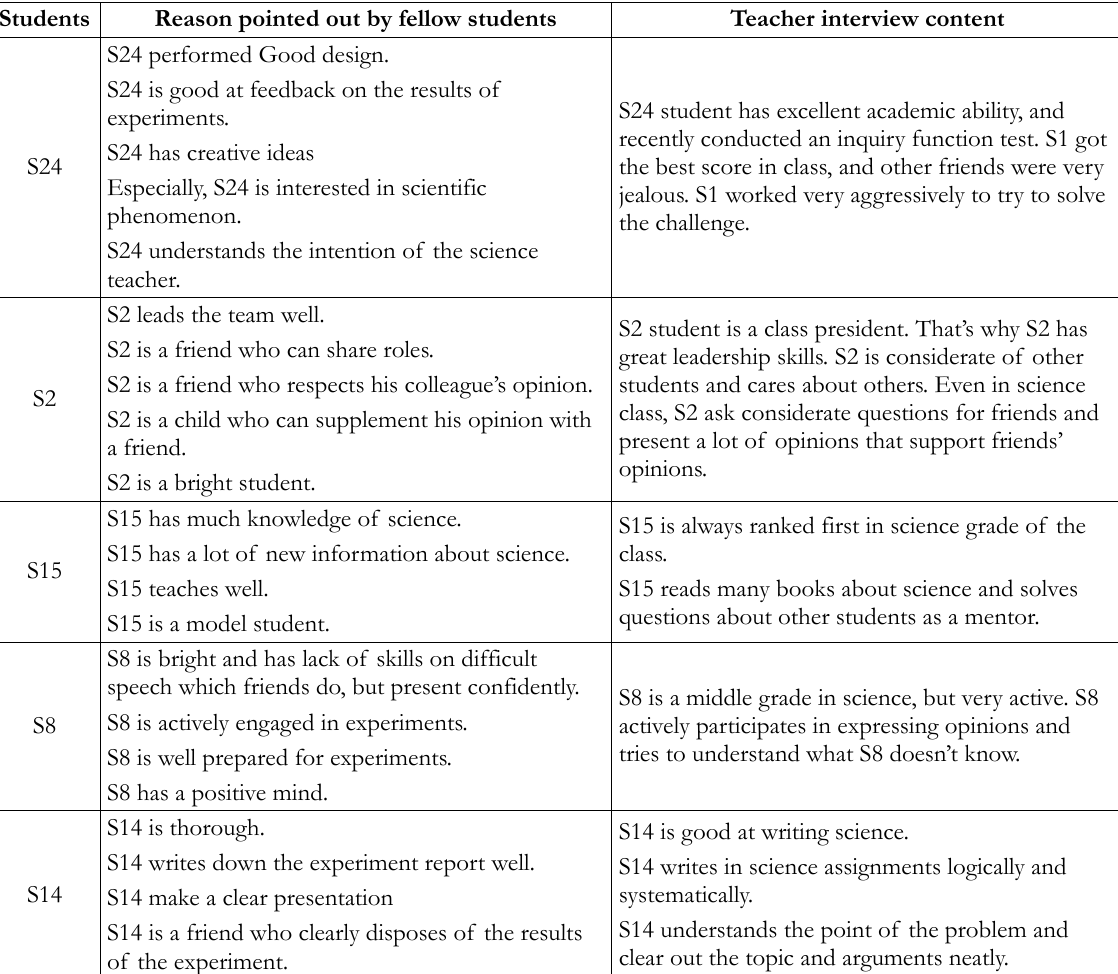
Table 10. Characteristics of Students with High Values of